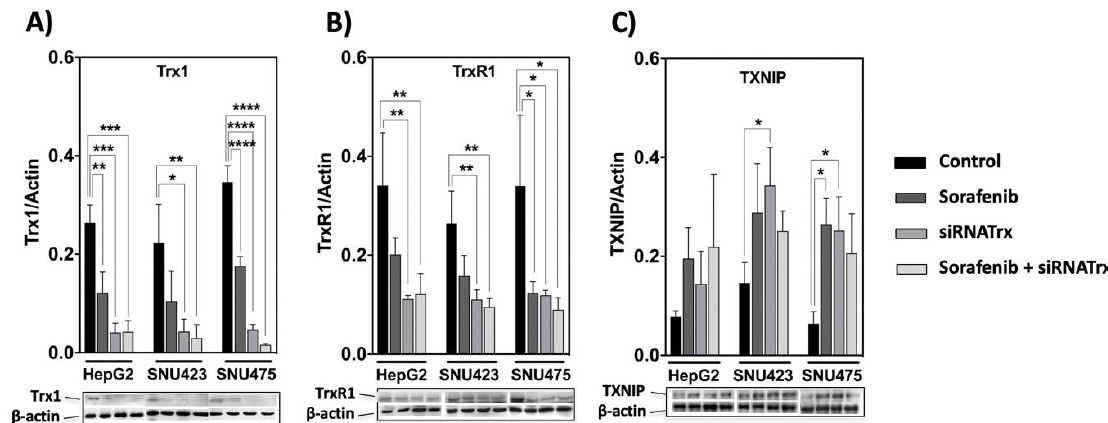
Figure 3. Response of the thioredoxin system to Sorafenib and siRNATrx1 treatments. Changes in the levels of three components of the thioredoxin system, ( A ) Trx1, ( B ) TrxR1 and ( C ) TXNIP were determined in HepG2, SNU423 and SNU475 cells by Western blotting with their specific antibodies on treatment with Sorafenib or siRNATrx1 independently or combined under the conditions described in M&M. Densitometric data normalized for ß-actin are shown; samples from 3 di ff erent experiments ( N = 3) for each cell line were run in the same gel; protein levels between cells cannot be compared since each set of 3 replicas for each cell line was developed on a di ff erent WB membrane; for a comparison of Trx1, TrxR1 between cell lines, refer to quantitative proteomic data in Figure 1; a composition of representative blots is shown below each graph. p values 0.0332 (*), 0.0021 (**), 0.0002 (***), < 0.0001 (****), see Materials & Methods for statistical details.